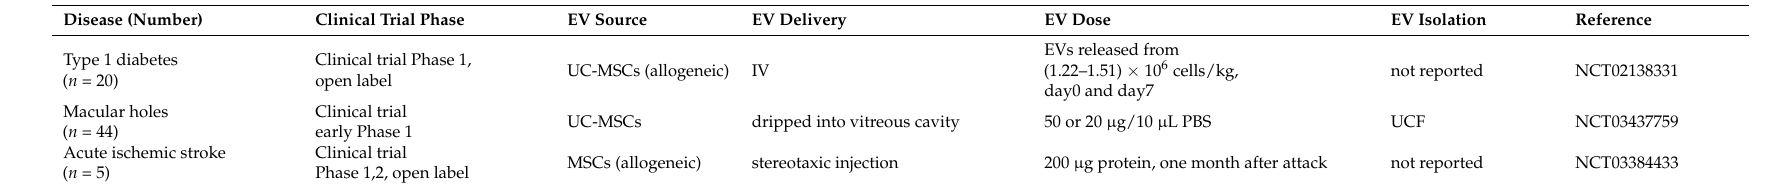
Table 2. Current and past NIH registered clinical trials investigating MSC-derived EV-based